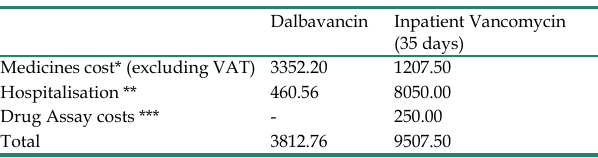
Table 1: Cost analysis comparing inpatient vancomycin and dalbavancin